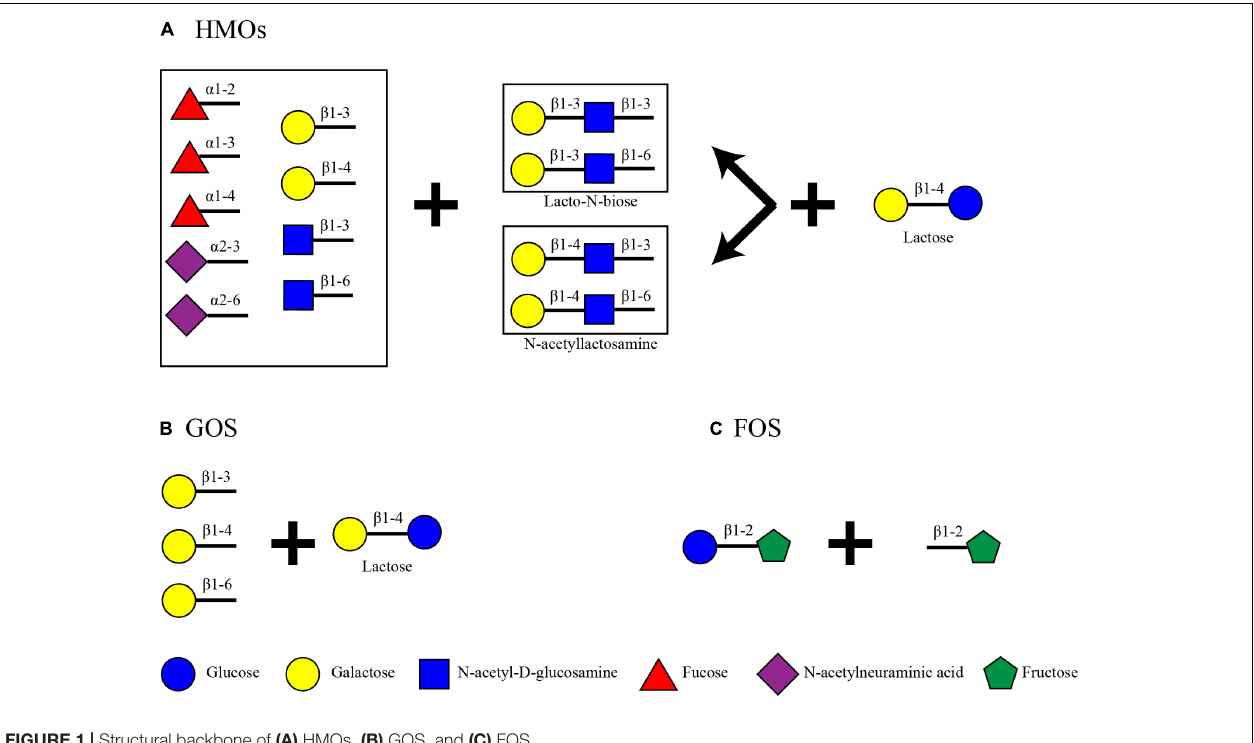
FIGURE 1 | Structural backbone of (A) HMOs, (B) GOS, and (C)